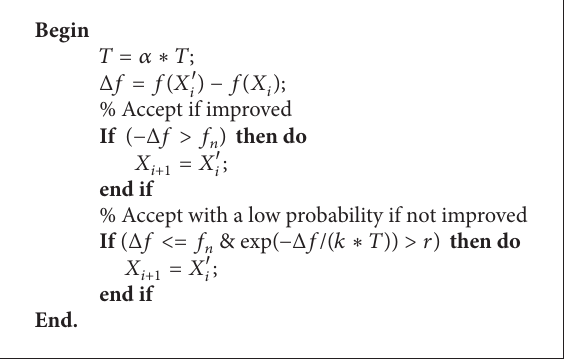
Algorithm 1: Krill selecting (KS)